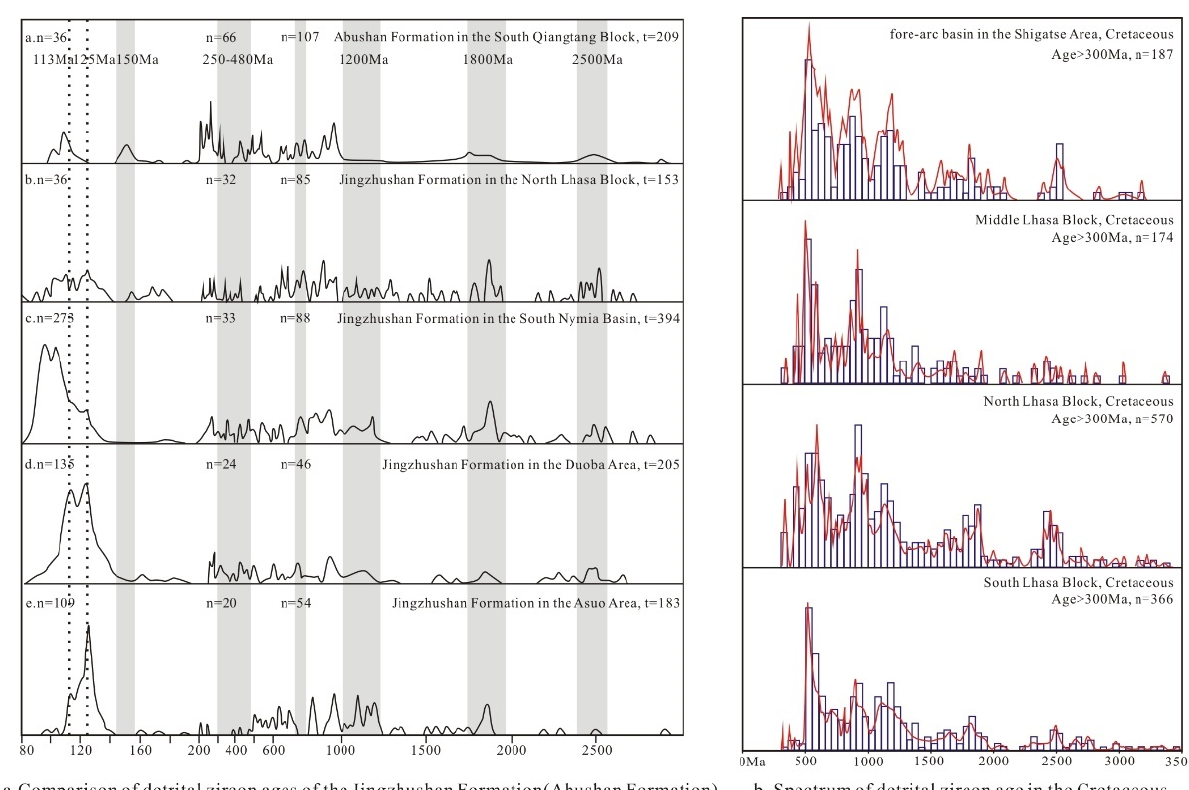
Figure 15. Age spectra of detrital zircon age in the Jingzhushan Formation and Cretaceous [61]. ( a ) Comparison of detrital zircon ages of the Jingzhushan Formation (Abushan Formation) in dif-ferent areas of the Lhasa Block and the South Qiangtang Block; ( b ) Spectrum of detrital zircon age in the Cretaceous.